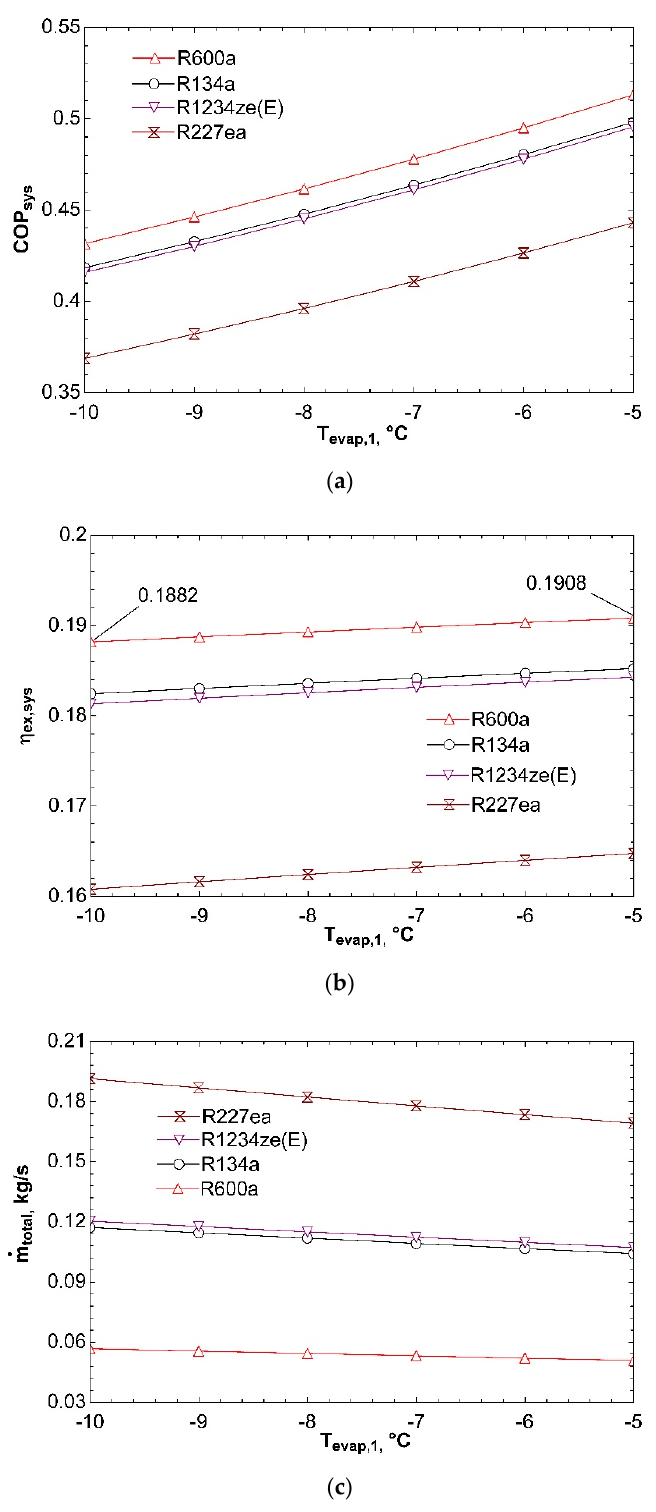
Figure 13. Effect of T evap,1 on COP sys ( a ), ƞ ex,sys ( b ), and ṁ total ( c ) in combined ORC-dual evaporator VCR Figure 13. E ff ect of T evap,1 on COP sys ( a ), η ex,sys ( b ), and ˙m total ( c ) in combined ORC-dual evaporator cycle. VCR Figure 14 clarifies how system performance is impacted with temperature of second evaporator. Increase of T evap,2 from 0 °C to 10 °C does not cause an important change in COP sys as can be detected